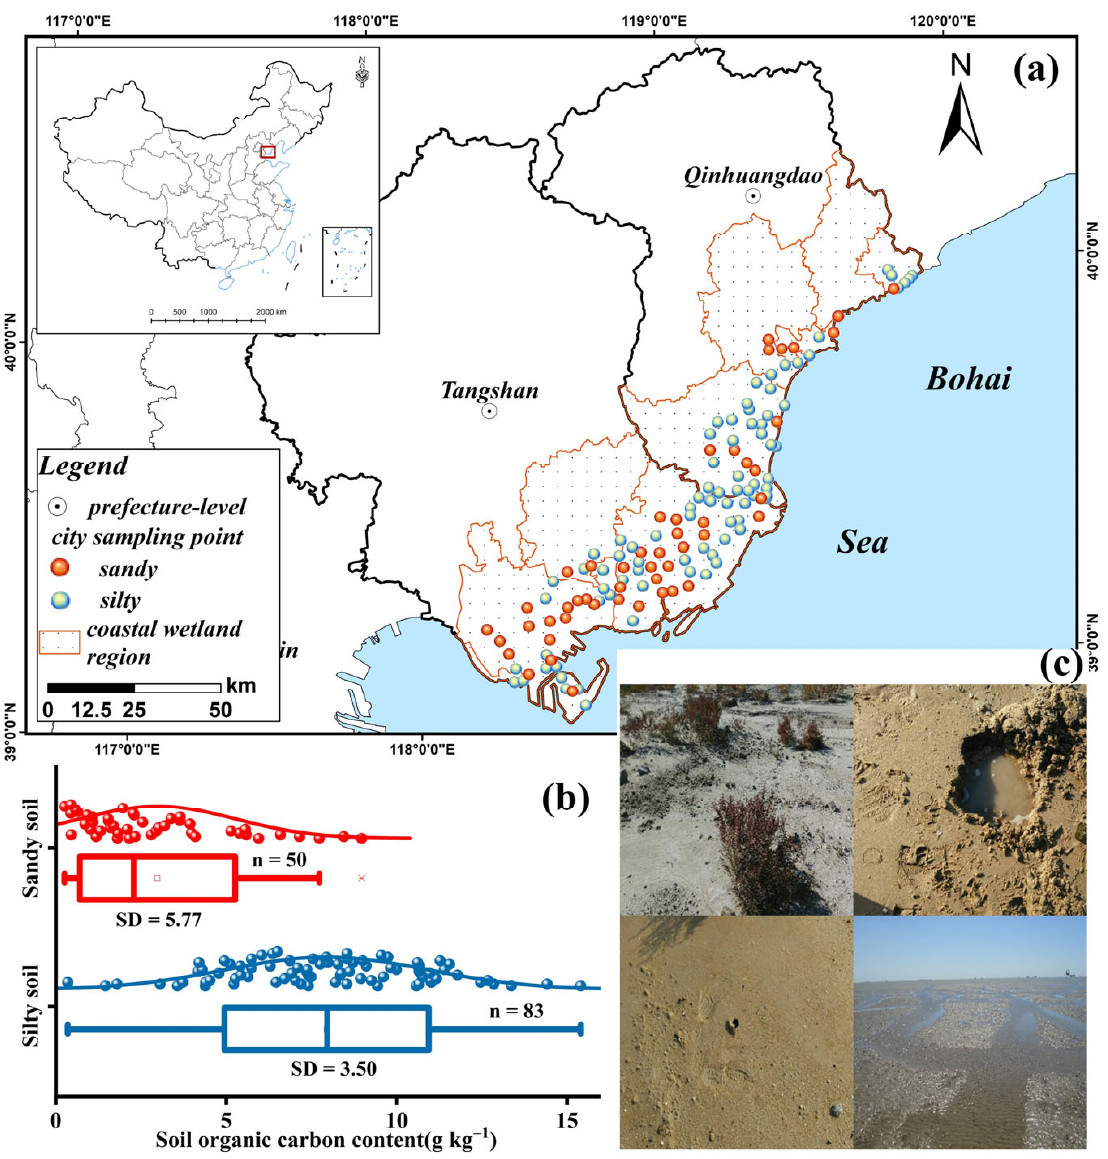
Figure 1. Geographic location of the study area. ( a ) Sample point distribution; ( b ) CW-SOC content statistics; ( c ) Coastal wetland soil.